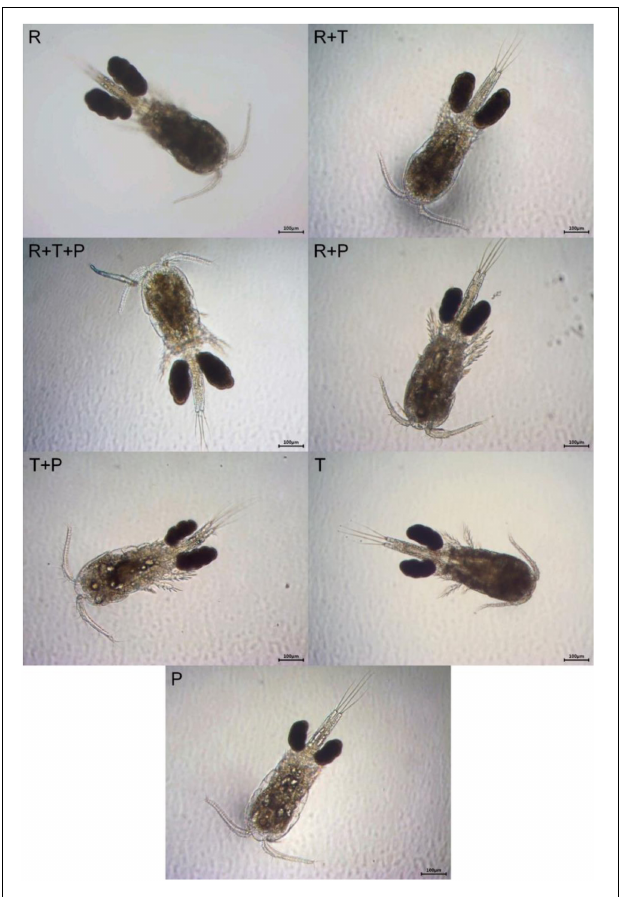
FIGURE 6 | Visual comparison of the body size and the size of the egg sacs of Paracyclopina nana ovigerous females fed on different microalgal diets. Additional supporting data on ovigerous females respective prosome length and clutch size can be found in Dayras et al. (2020). R, Rhodomonas salina ; T, Tisochrysis lutea ; P, Pavlova